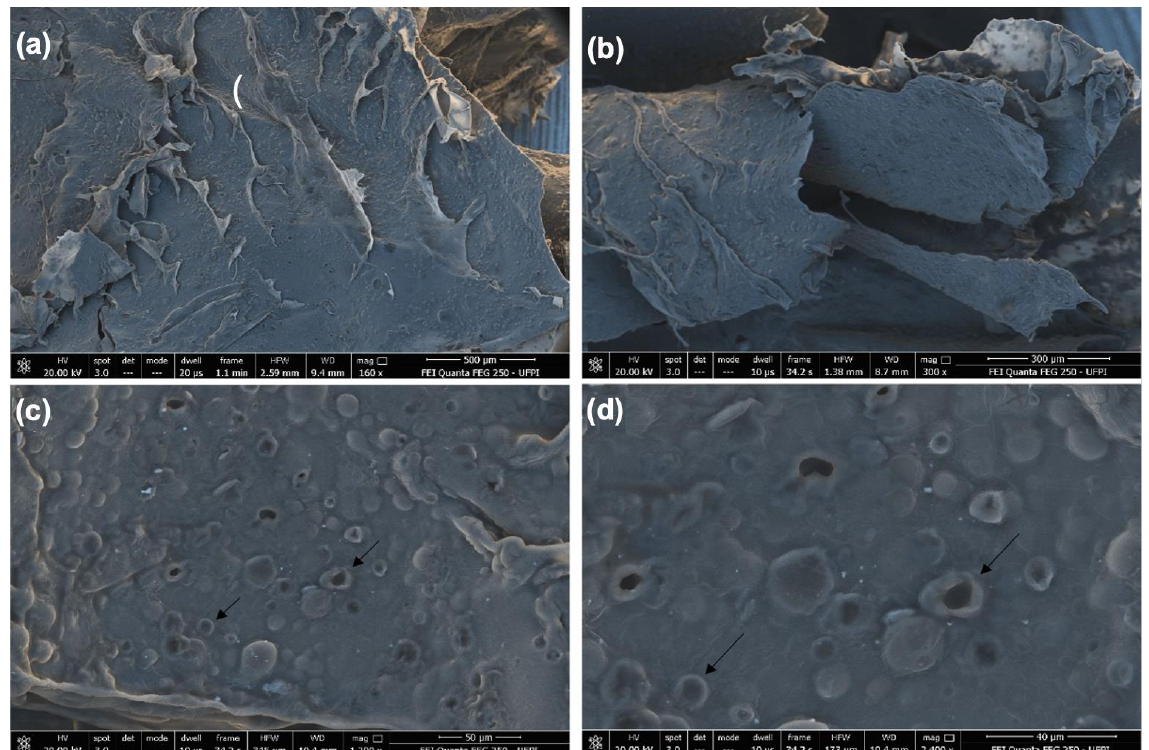
Figure 2. Scanning electron microscope (SEM) images of chicha gum/chitosan/ Mauritia flexuosa oil gel (CGCHO) at the magnitudes of ( a ) 500 µm, ( b ) 300 µm, ( c ) 50 µm and ( d ) 40 µm.